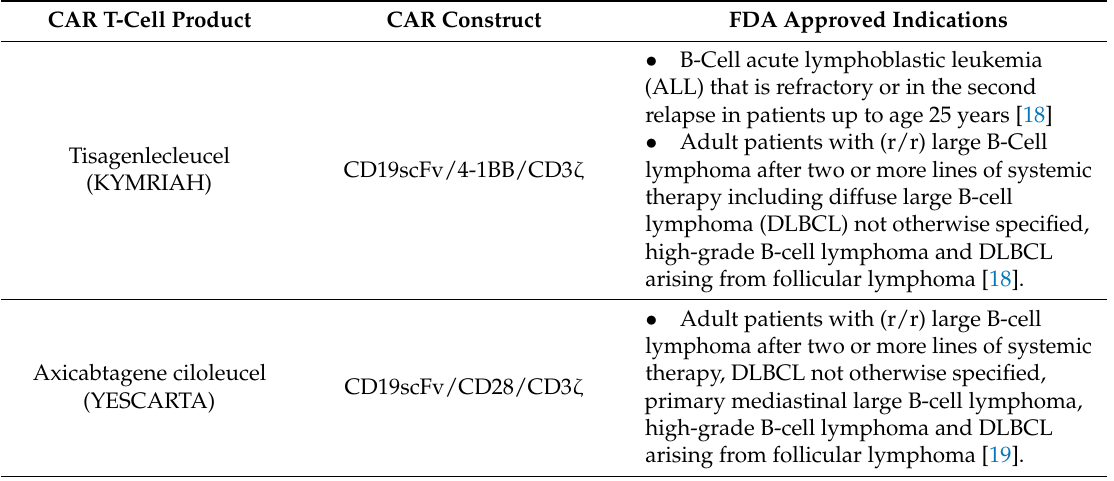
Table 1. Approved U.S. Food and Drug Administration (FDA) Indications for Chimeric antigen receptor T-cell (CAR T-Cell) Therapy.